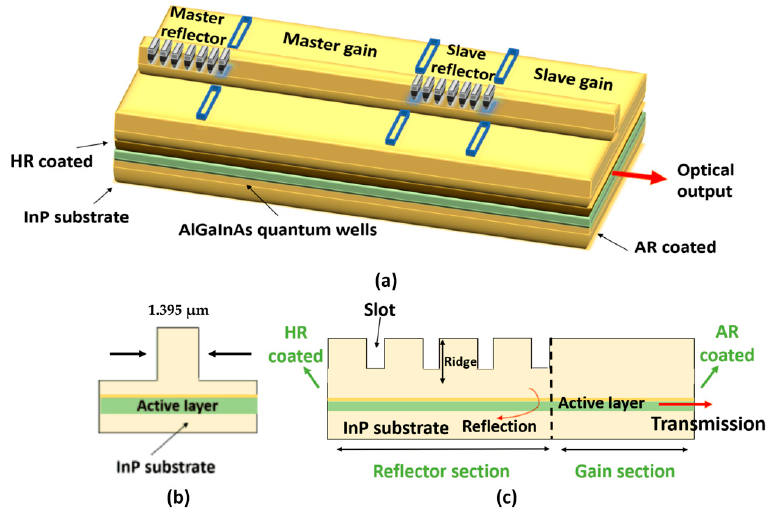
Figure 1. ( a ) InP multi-section photonic integrated circuit (PIC) 3D schematic diagram; ( b ) 2D side view of the waveguide structure; and ( c ) 2D two section single laser waveguide structure.